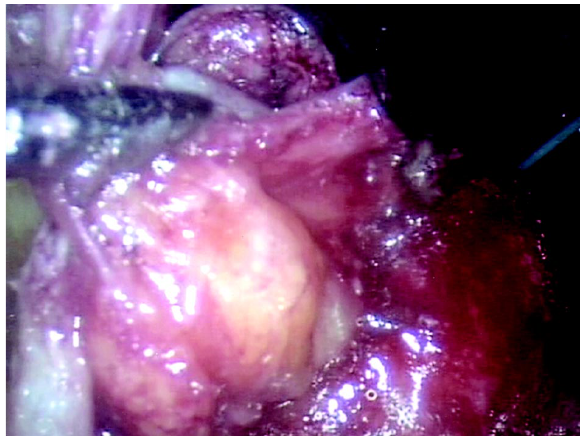
Figure 3 – Laparoscopic view of the tumor area to be resected. Figure 4 – Technical transoperative detail of laparoscopic par- tial cystectomy.